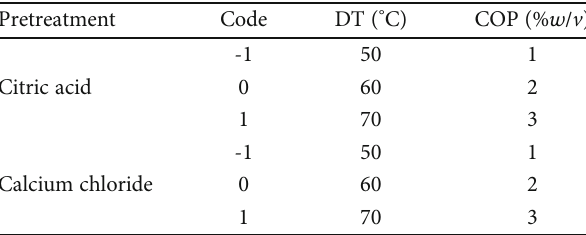
Table 1: Levels of independent variables used for central composite design.